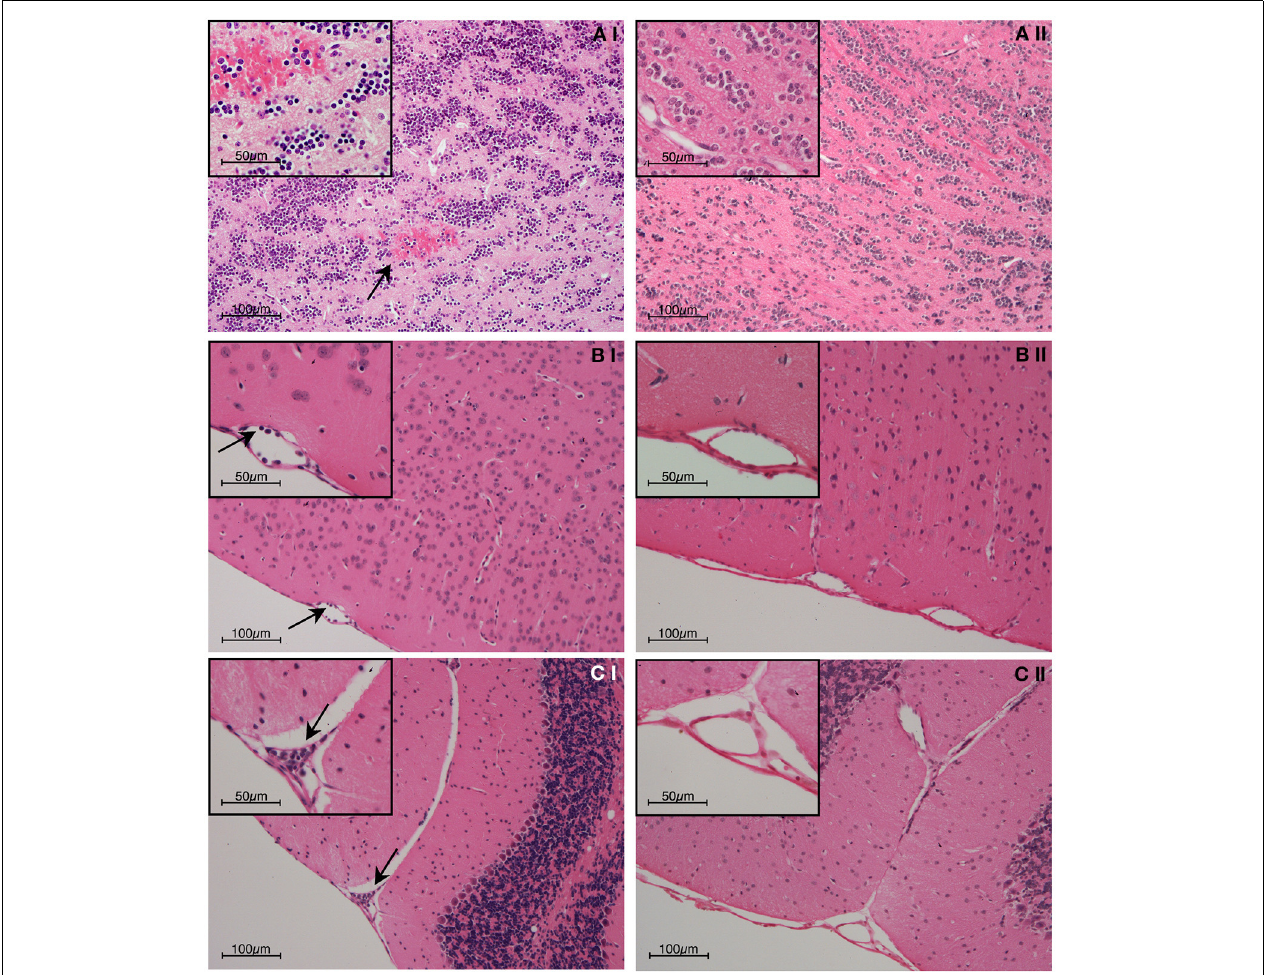
mice showed hemorrhage and leukocyte adhesion to the cerebral vasculature (arrows), whereas no pathological findings were evident